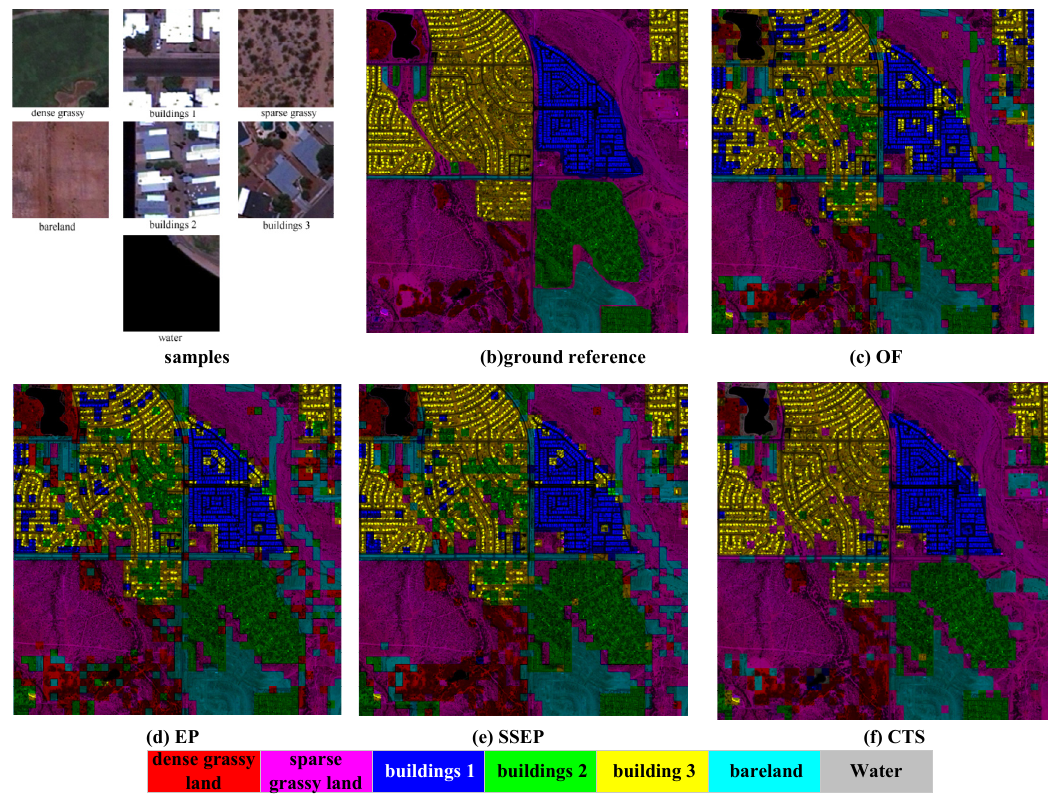
Figure 10. Classification result on the Scene-TA Dataset ( a ) The original image ( b ) Ground reference data ( c ) OF result ( d ) EP result ( e ) SSEP result ( f ) CTS result.